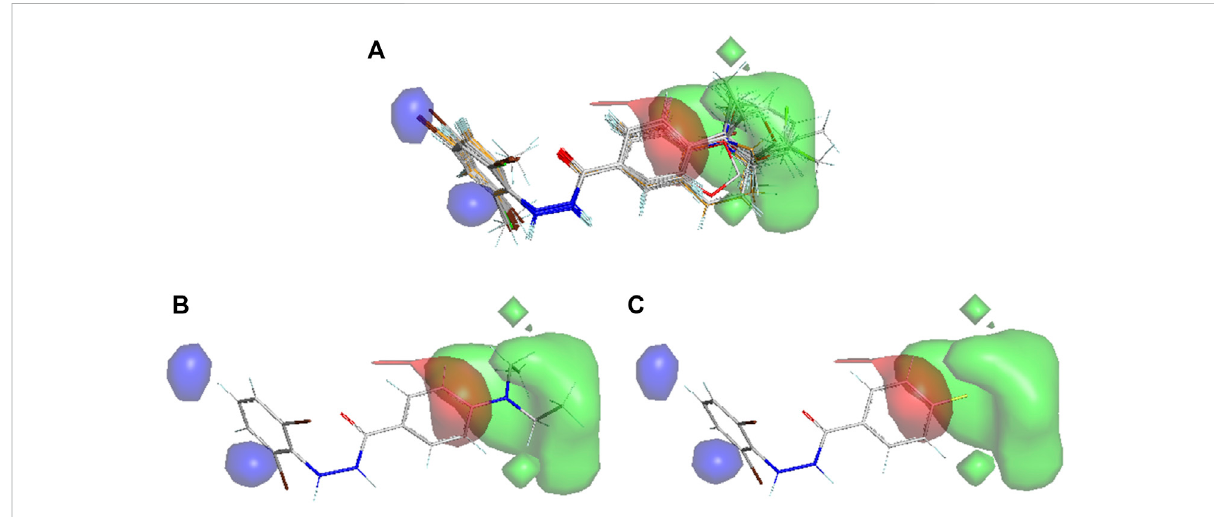
FIGURE 7 Contour maps obtained from the best 3D-QSAR model (Green: Steric favorable, Blue: Electropositive favorable; Red: Electronegative favorable). (A) Aligned conformations of all compounds, (B) the best active compound 11p and (C) the least active compound 10l .